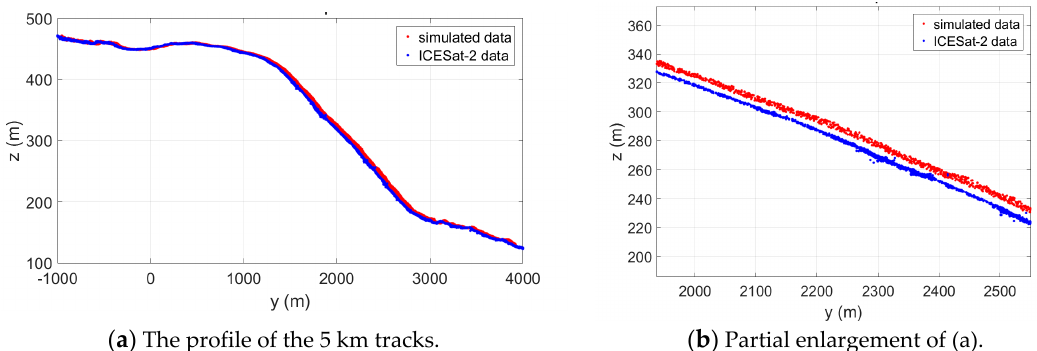
Figure 12. The simulated spaceborne photon-counting track (red) and the corresponding ICESat-2 track (blue). ( a ) is the profile of the 5 km data and ( b ) is a partial enlargement of ( a ).